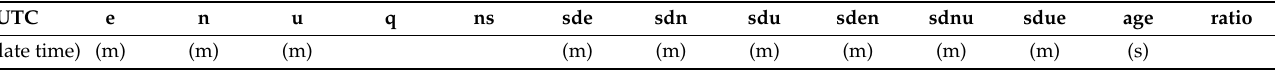
Table A2. Column names in the output .ENU solution files, generated by the buried Emlid